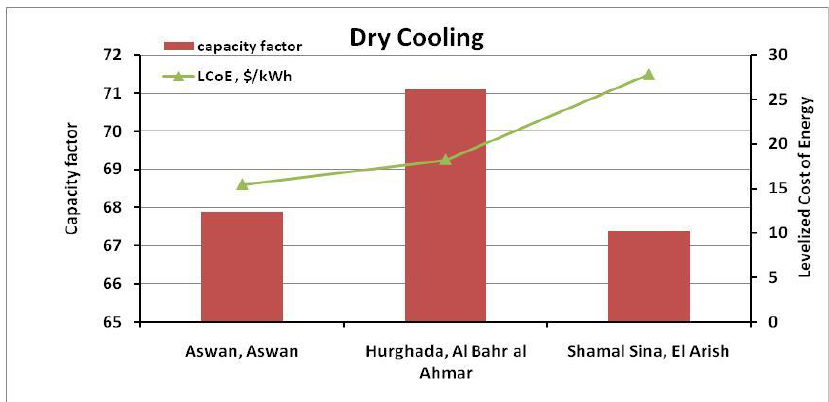
Fig. 6. Capacity factor and LCoE with location (wet